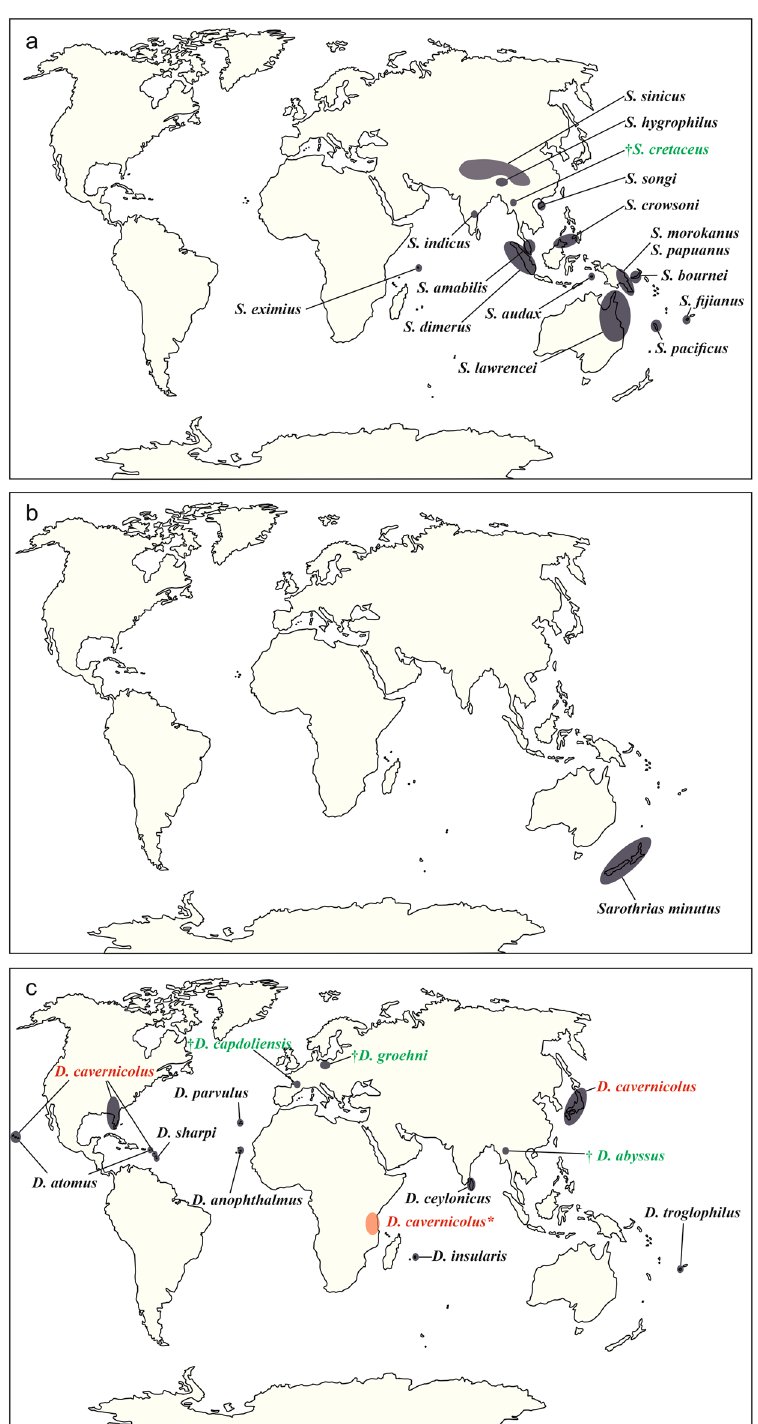
Figure 1. Distribution map of the Jacobsoniidae species with the fossil representatives indicated with †. The information is updated from Háva 2 ( a ). Sarothrias spp.; ( b ). Saphophagus spp.; ( c ). Derolathrus spp., with the widespread distribution of D. cavernicolus . Fossil species are highlighted in green. Derolathrus cavernicolus indicated in red, with * denotes a probably extinction in the